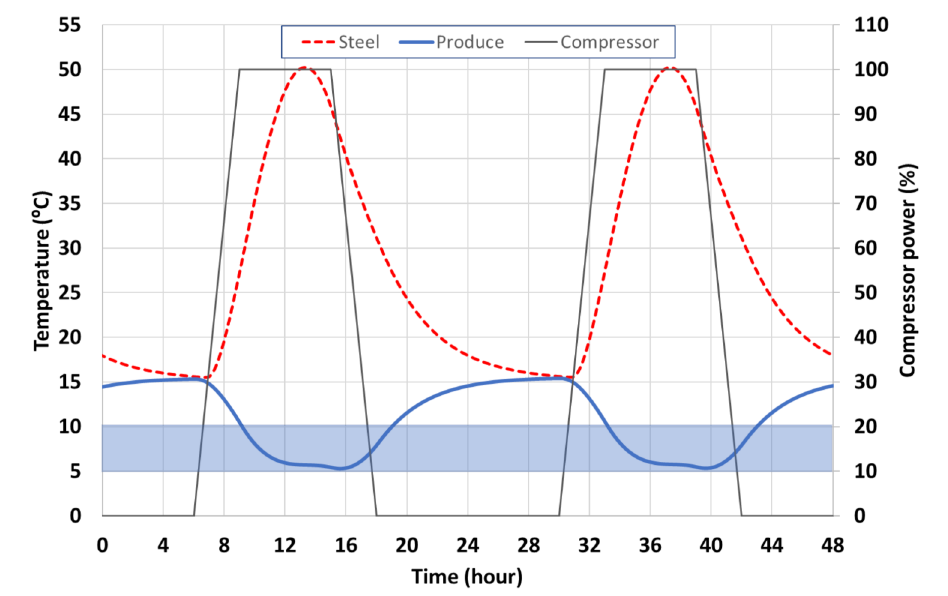
Figure 21. Produce temperature over a period of 48 h.